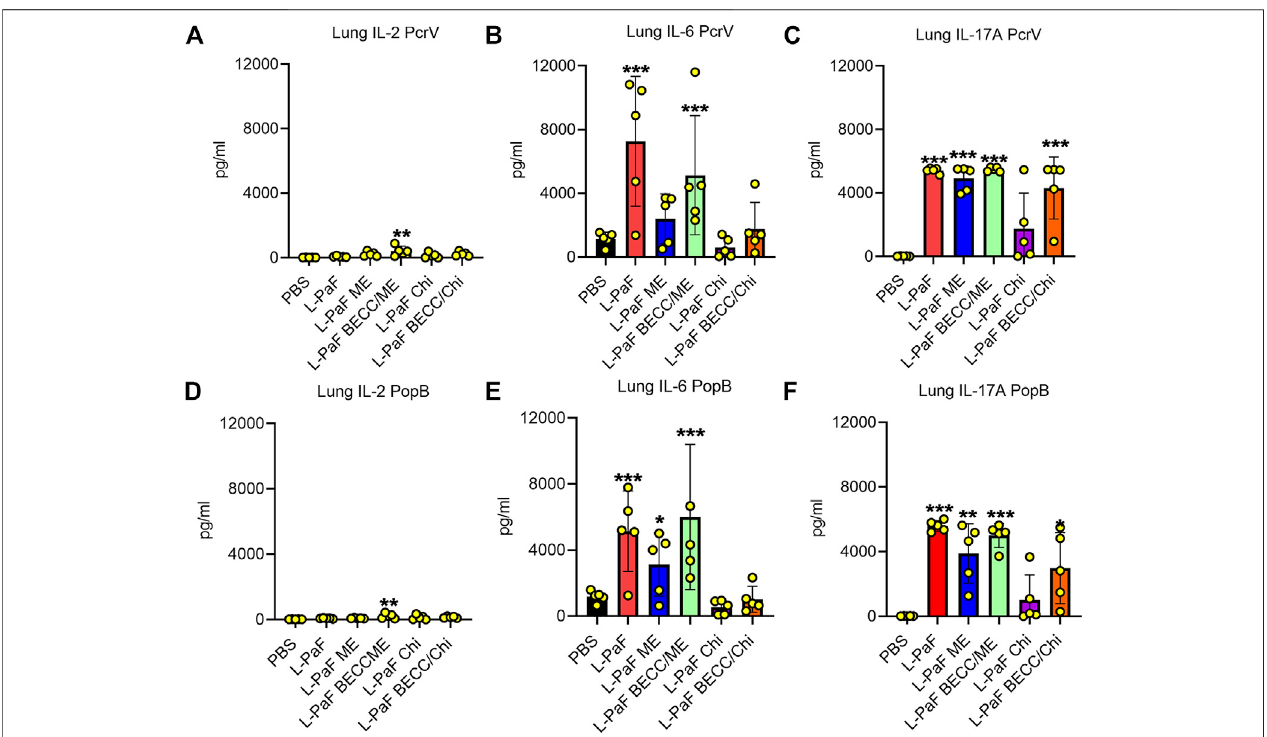
FIGURE 6 | Lung cells secretes pro-in fl ammatory cytokines following stimulation with PcrV or PopB. Lung cell suspensions were prepared and single cell suspensions were treated with 10 μ g/ml of either PcrV or PopB and incubated for 48 h at 37 ° C. Secretion of IL-2 (A, D) , IL-6 (B, E) and IL-17A (C, F) were noted as a response of either PcrV or PopB stimulation. Amounts of cytokines were determined by MesoScale Discovery (MSD) analysis as per manufacturer ’ s instructions and were presented as pg/ml/10 6 cells. Data were plotted as actual values from individuals ± SD (n (cid:2) 5) in each group. Statistical signi fi cance was calculated by comparing the PBS group with their immunized counterparts using two-way ANOVA (Dunnett ’ s multiple comparison test). * p < 0.05, ** p < 0.01, *** p < 0.001.